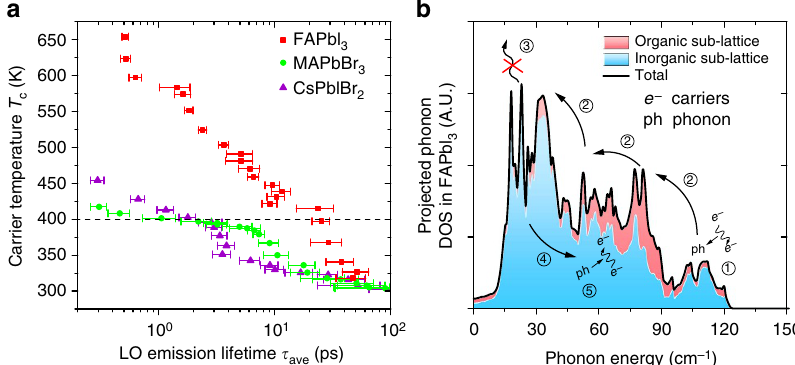
Figure 4 | Phonon dynamics and bottleneck effect in lead-halide perovskites. ( a ) Carrier temperature-dependent phonon emission lifetime in different lead- halide perovskites with a similar initial carrier concentration of around 2 (cid:3) 10 18 cm (cid:2) 3 . The error bars shows the standard error of the average (s.e.m) emission lifetime. An emission lifetime that is about 10 times longer than the other materials is observed in FAPbI 3 with carrier temperature at and below 400K; ( b ) Proposed phonon dynamics in the FAPbI 3 . The solid black line shows the total phonon DOS, in which the contributions from the inorganic and organic sub-lattices are shown by the blue region on the bottom with the pink region stacked on top, respectively. The labelled phonon dynamic process are: (1) Fro¨hlich interaction of carriers primarily on the lead-halide framework; (2) relaxation of lead-halide LO phonon, organic sub-lattice can be excited by phonon–phonon scattering; (3) propagation of acoustic phonon is blocked due to anharmonic phonon–phonon scatterings; (4) up-conversion of acoustic phonons; and (5) carrier